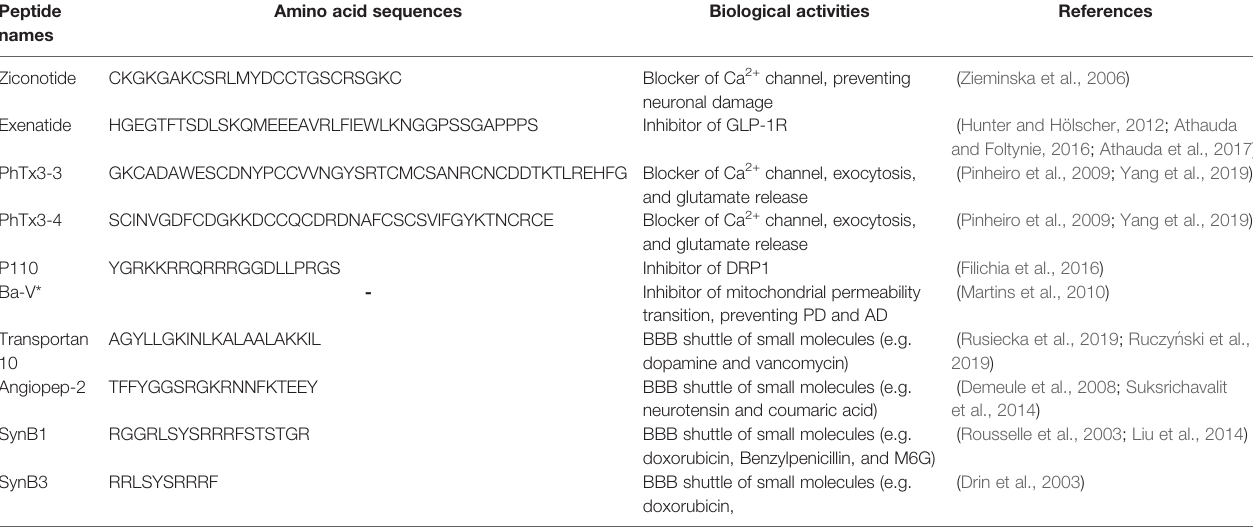
TABLE 2 | List of names, primary structure, biological activities, and references for the cited peptides with therapeutic effect against neurodegenerative diseases, as well as BBB shuttle